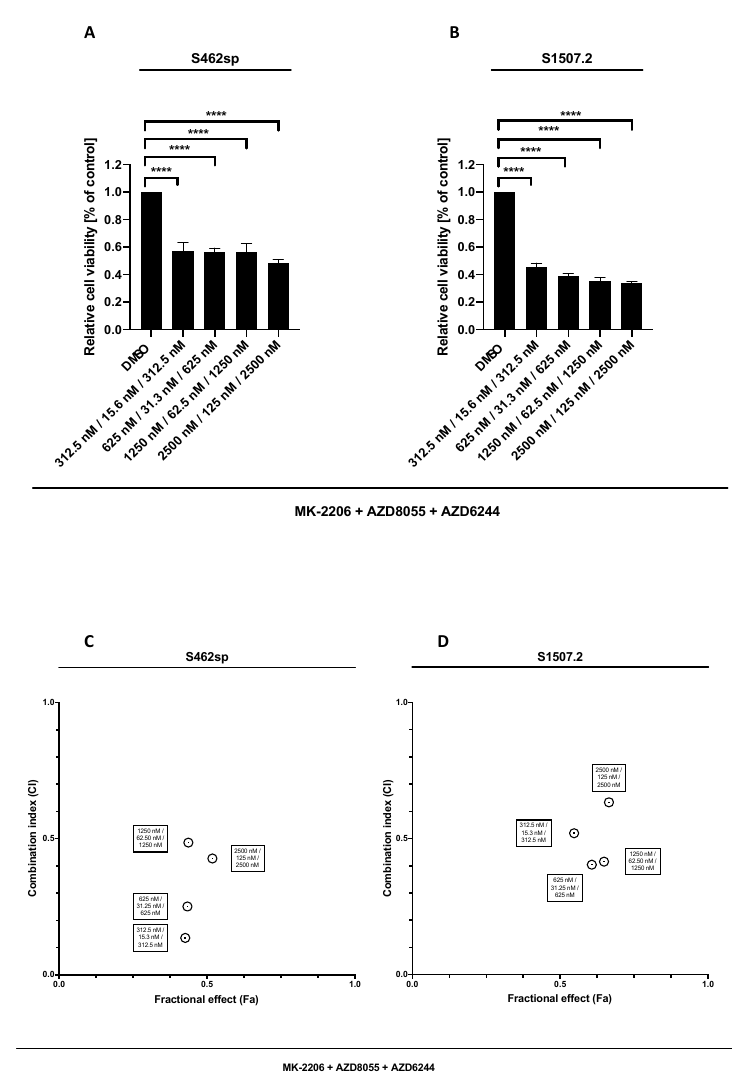
Figure 3. MPNST cell viability after triple treatment with MK-2206, AZD8055 and AZD6244 in vitro. MPNST cells were seeded in a 96-well-plate at a density of 5000 cells per well. Relative cell viability (normalised to control) of S462sp ( A ) and S1507.2 ( B ) cells under varying concentrations of combined MK-2206, AZD8055 and AZD6244 treatment was measured in an XTT assay after 72 h. The mean values with standard deviation are shown. Statistical significance was analysed with a one-way ANOVA with Dunnett’s multiple comparisons test and compared to the vehicle substance dimethyl sulfoxide (DMSO) (**** p ≤ 0.0001). Combination indices (CI) were calculated based on the XTT assay (Figures 2 and 3) according to the Chou and Talalay method and plotted against their respective fractional e ff ect (Fa) on cell viability (very strong synergism CI < 0.1; strong synergism CI 0.1–0.3; synergism CI 0.3–0.7; moderate synergism CI 0.7–0.85; slight synergism CI 0.85–0.90; nearly additive CI 0.9–1.10; antagonistic CI > 1.1). The data for triple targeting with MK-2206, AZD8055 and AZD6244 on S462sp ( C ) and S1507.2 ( D ) compared to dual treatment with MK-2206 and AZD8055 is